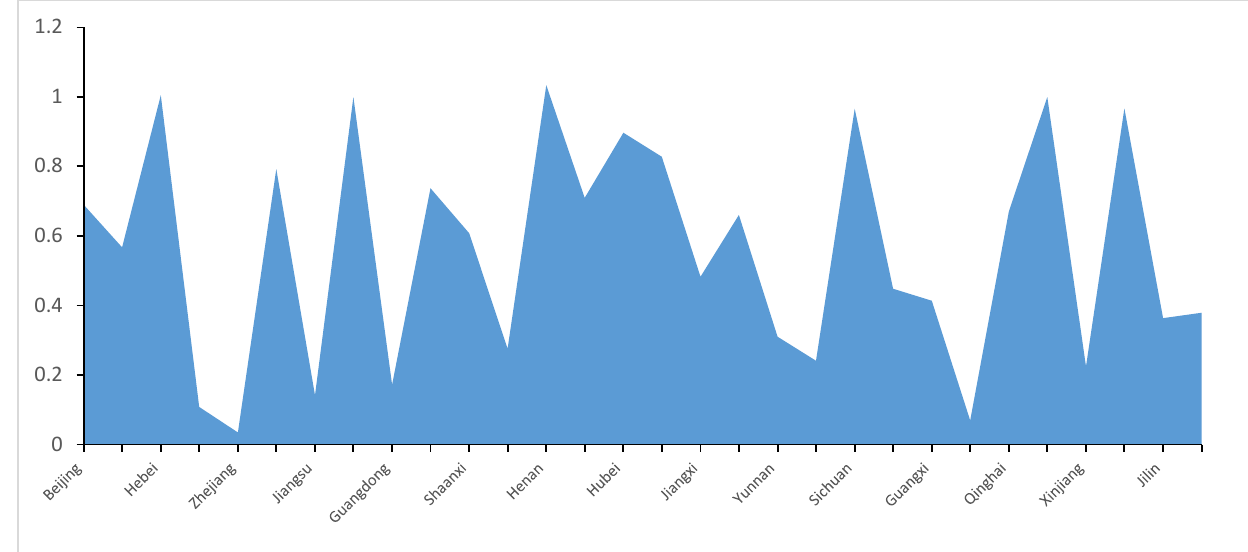
Figure 3. Return to scale